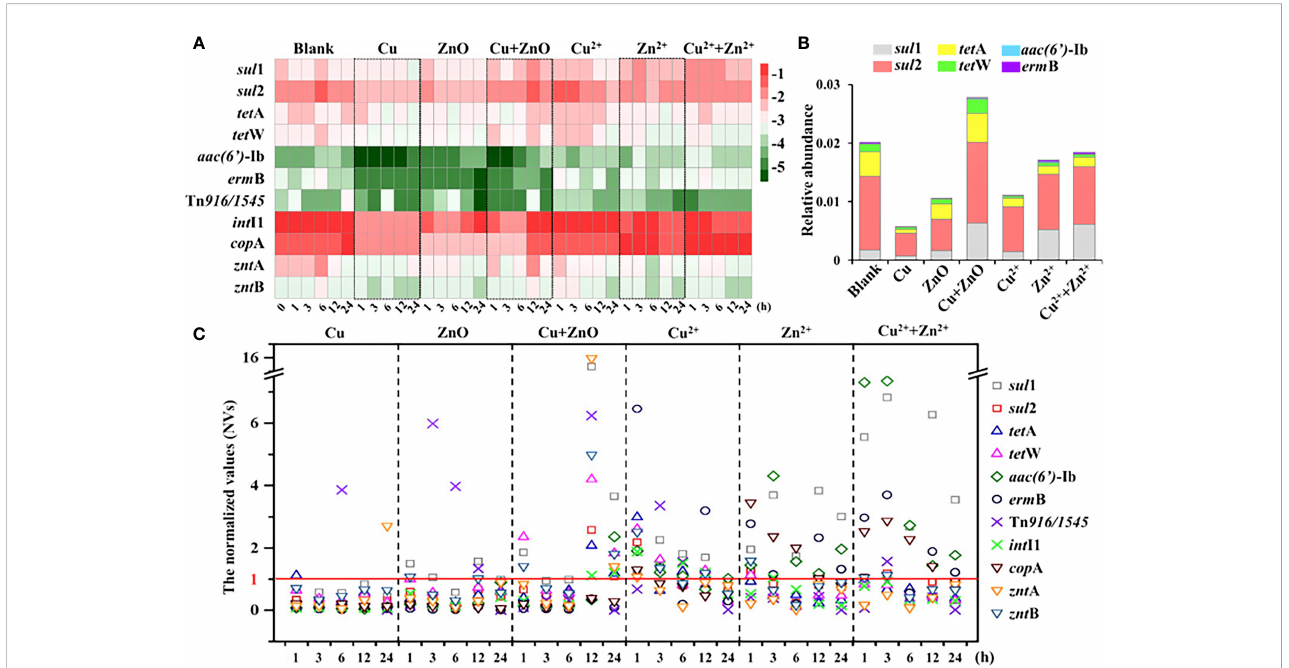
FIGURE 1 The abundance of target genes. (A) the relative abundance (log 10 (copies/16S rRNA)) of target genes in all the samples at different exposure time; (B) the relative abundance (ARGs copies/16S rRNA copies) of ARGs at 24h; (C) The normalized values (NVs) of ARGs during exposure experiment in all the treatments. The NV >1 indicated the abundances of ARGs were enhanced when exposed to NPs or metal ions, at certain time; the NV <1 indicated the abundances of ARGs were reduced when exposed to NPs or metal ions, at certain time. The labels of Cu, ZnO and Cu+ZnO represent the groups with Cu NPs, ZnO NPs and Cu+ZnO NPs,